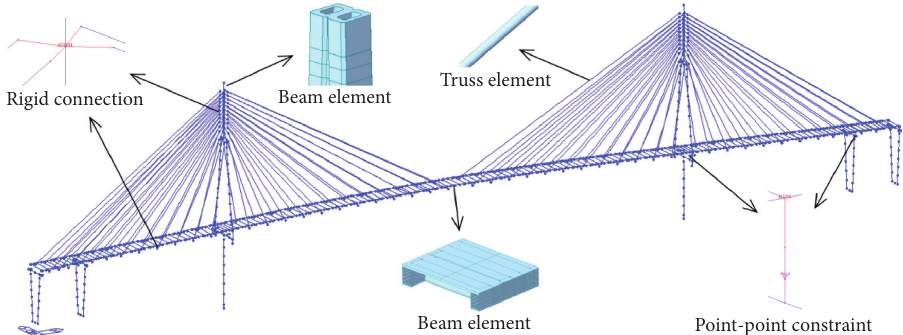
Figure 6: The finite element model with a beam element schematic